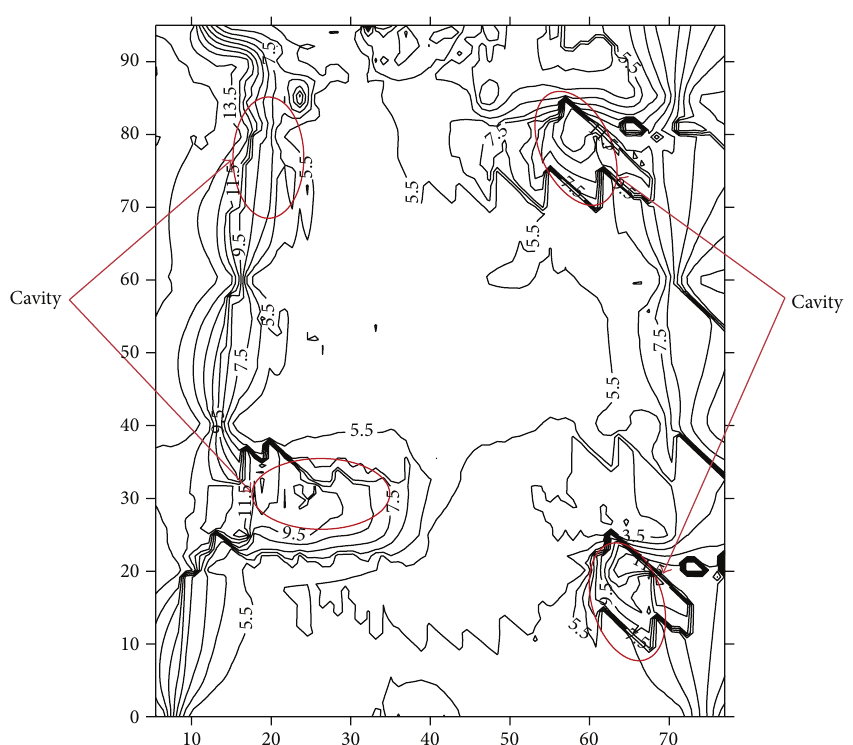
Figure 13: 2D representation of the topography of the study area (red circles show the location of the cavities).